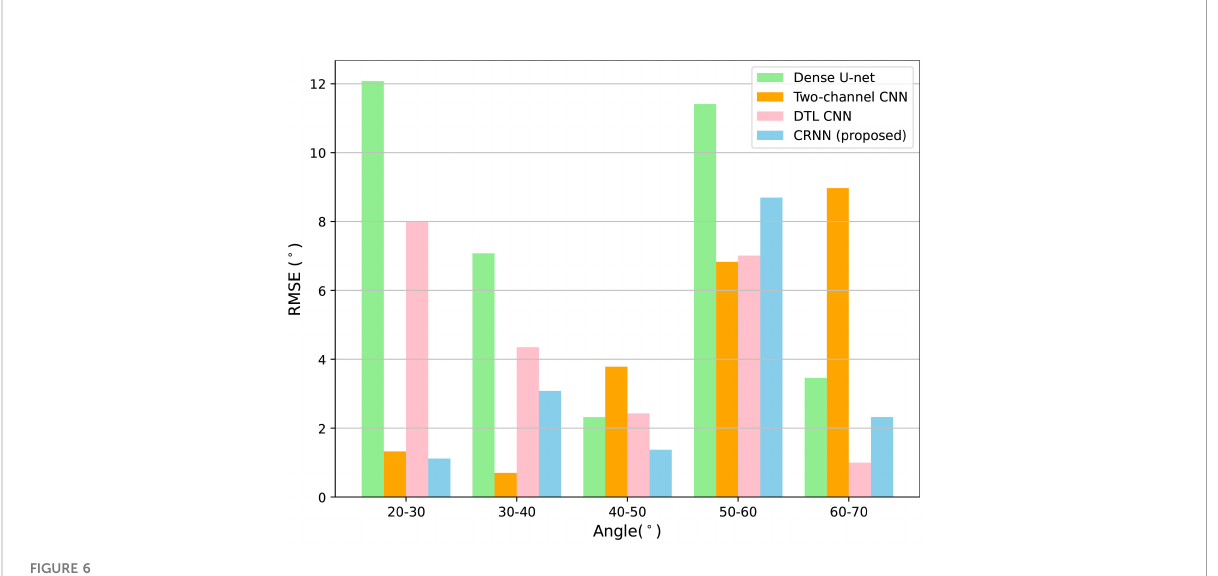
FIGURE 6 DOA estimation results in different intervals of